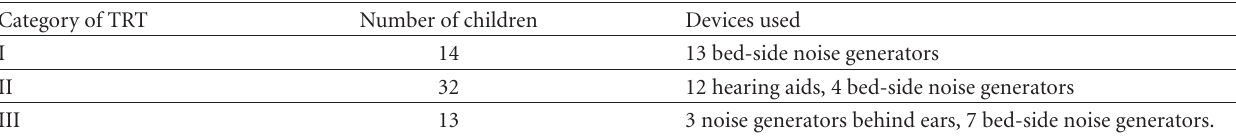
Table 3: The number of children in each category of TRT who used recommended devices.